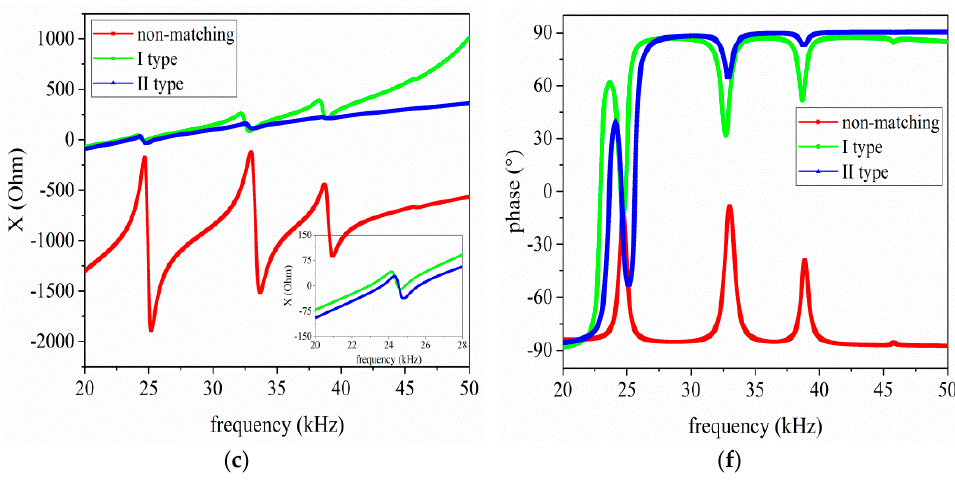
Figure 11. The impedance analysis results of the pitch-catch setup with EIM network, ( a ) electrical impedance; ( b ) resistance; ( c ) reactance; ( d ) electro-acoustic power ratio; ( e ) electro-acoustic gain ratio; and ( f ) electrical impedance phase.